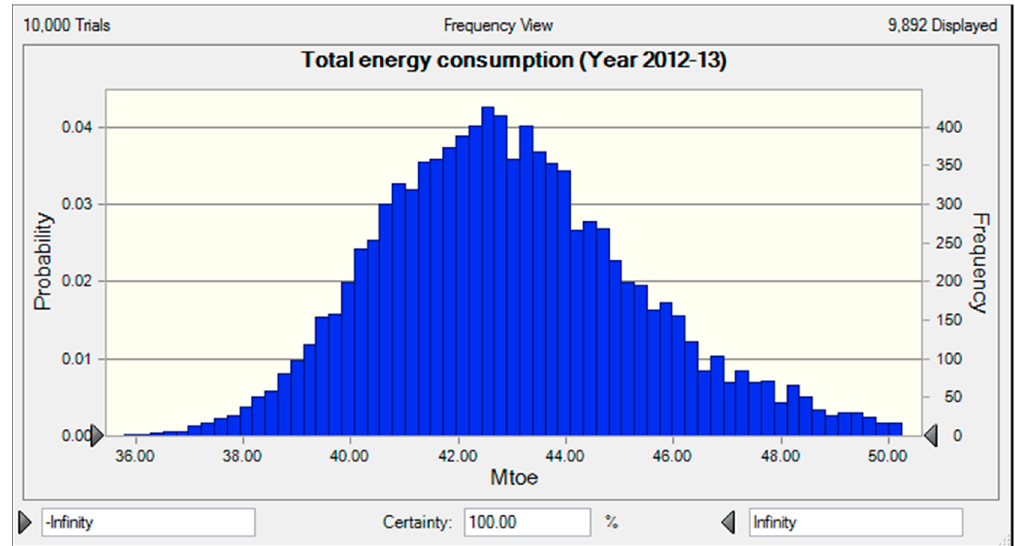
Figure 3. Frequency chart for total energy consumption year 2012–2013.